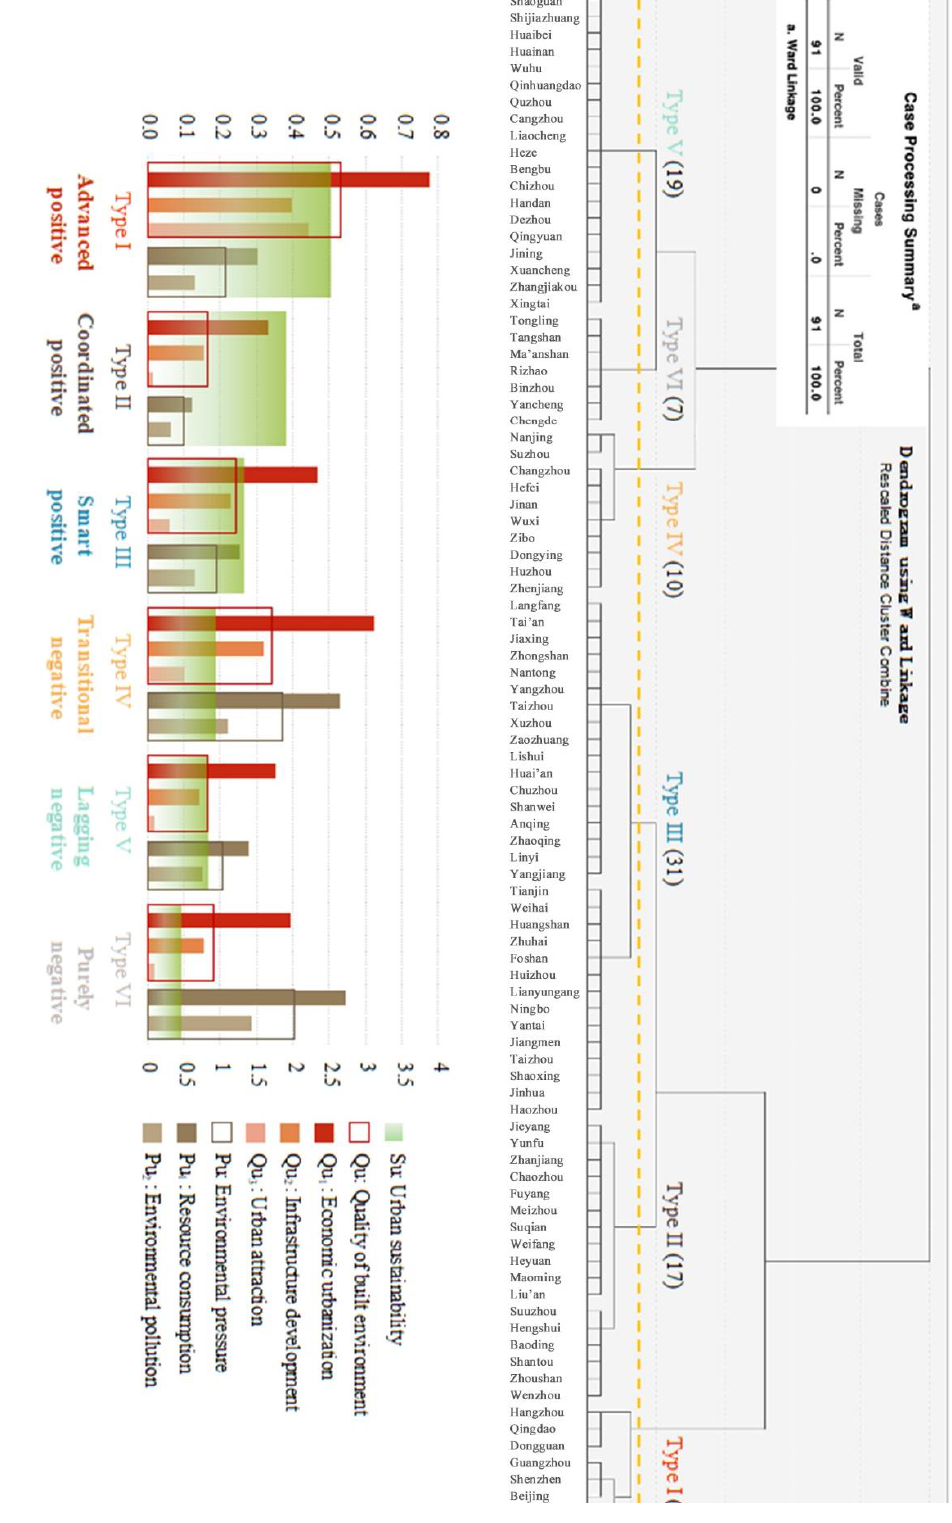
Figure 9. Result of hierarchical Clustering and comparison of the mean evaluation scores of each indicator categories among six types of cities in 2018.